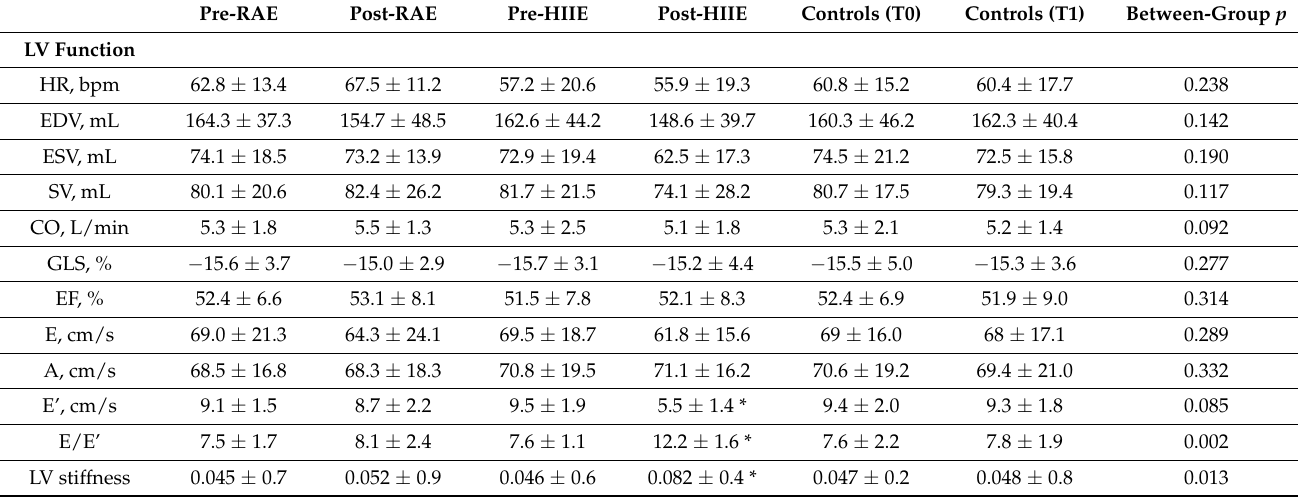
Table 1. Echocardiography parameters before and after experimental sessions.